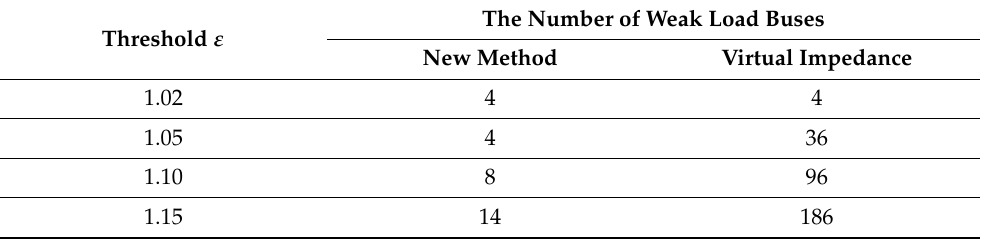
Table 7. Number of the weak load buses for the 1010-bus utility system with the different voltage stability